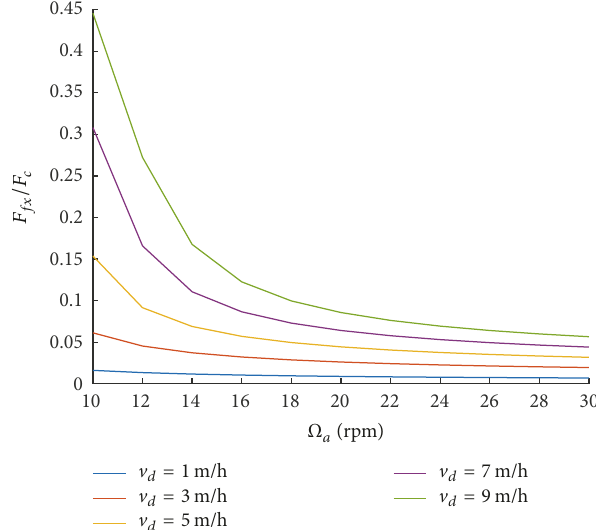
Figure 14: Influence of amplitude of drill string torsional oscillation on the change in axial